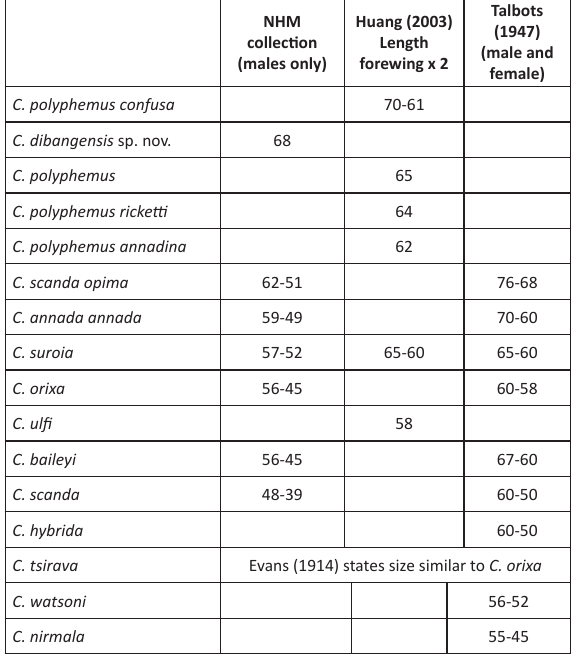
Table 3. Approximate expanse of Callerebia